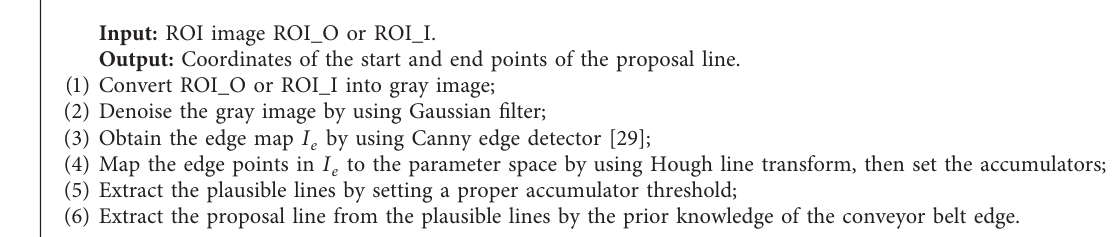
� 43, s � 0.4, and c �− 0.5, − 0.3, − 0.1, 0.1, 0.3, and 0.5. (b) r i j k